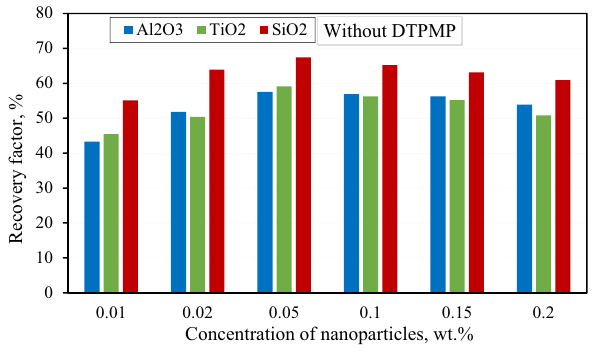
Fig. 7 The changes in recovery factor during LSWI in the presence of TiO 2 , Al 2 O 3, and SiO 2 at their various concentrations (at a salinity of 2500 ppm, without DTPMP, after 5